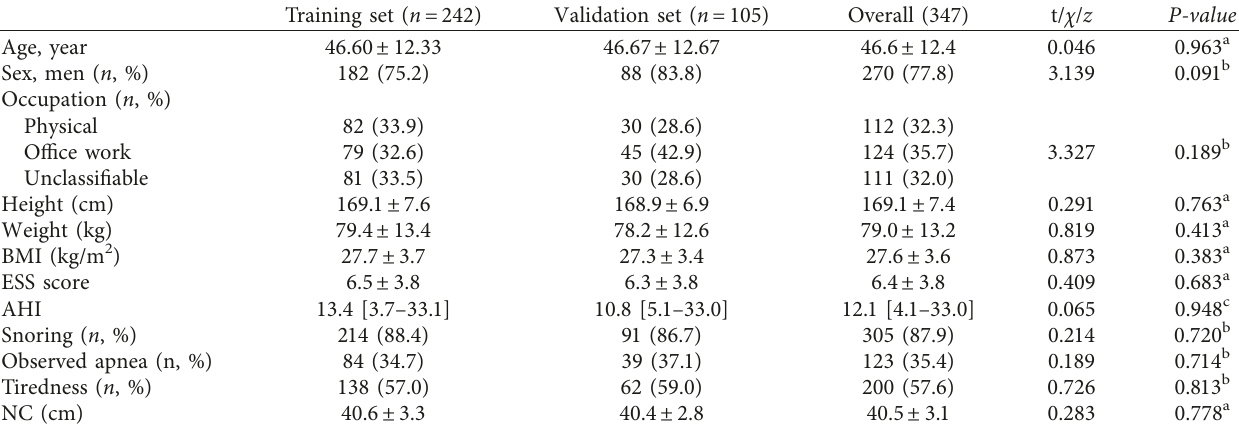
Table 1: Characteristics of the subjects by validation set and training set.